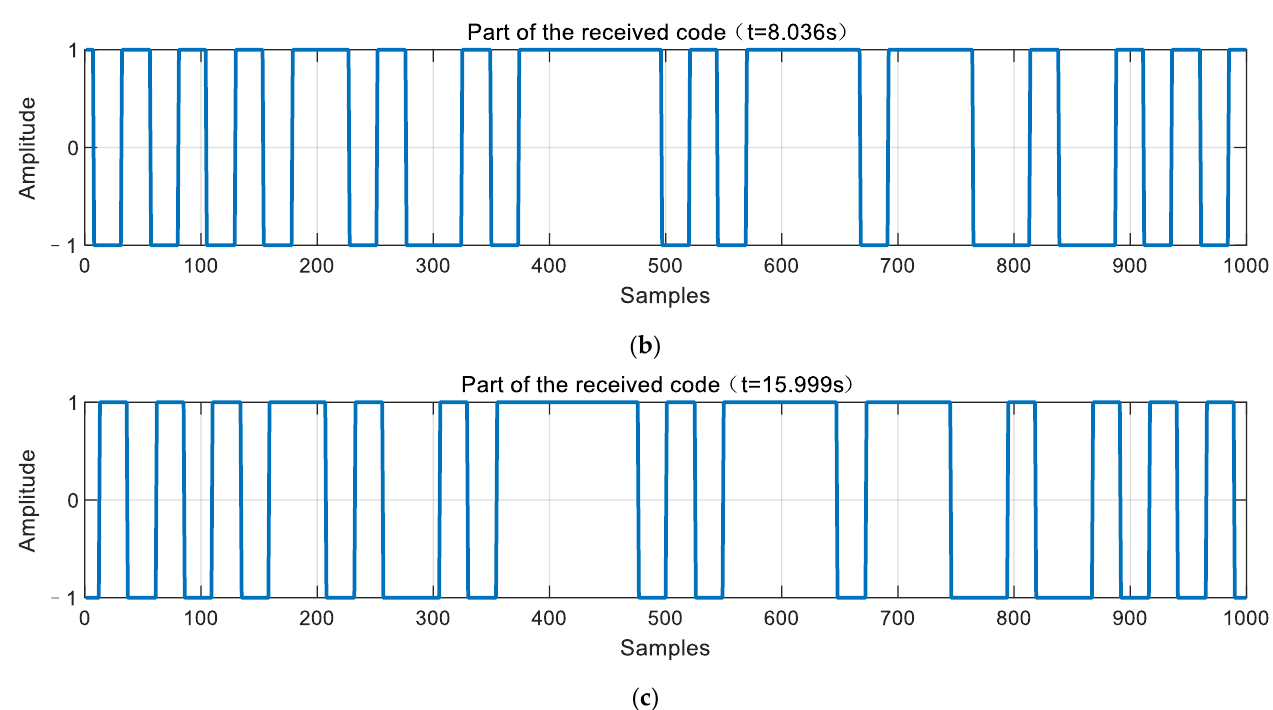
Figure 9. Transition process of the received PRN code. ( a ) Initial form of received PRN code; ( b ) Intermediate form of the received PRN code; ( c ) Final form of the received PRN code.